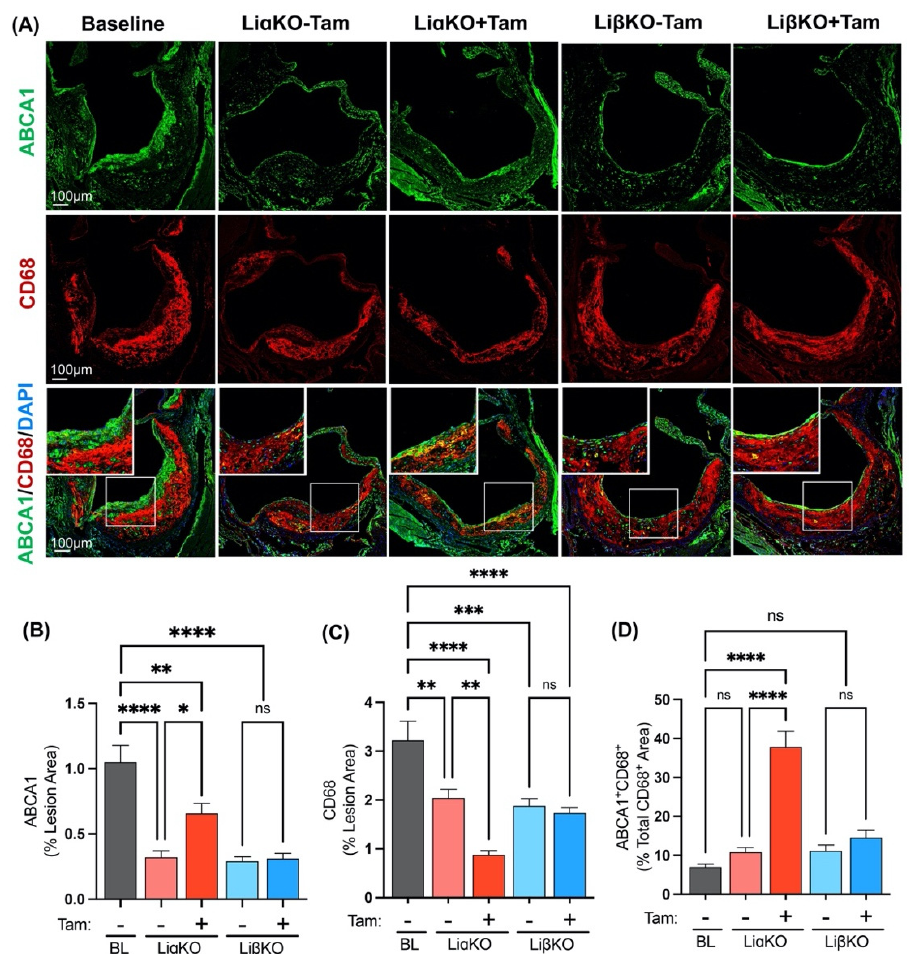
Figure 5. Elevated ABCA1 expression in GSK3 α -deficient macrophages from female Ldlr − / − mice. ( A ) Representative sections of aortic sinus immunostained with an antibody against ABCA1 (green) and co-stained with CD68 (red). Quantification of ( B ) ABCA1 and ( C ) CD68 area normalized to the total lesion area. ( D ) Quantification of co-stained (ABCA1 and CD68, yellow) area normalized to the total CD68 (macrophage, red) stained area. n = 5–7; mean ± SEM; * p < 0.05, ** p < 0.01, *** p < 0.001, **** p < 0.0001 (one-way ANOVA). ns, not significant; Tam, tamoxifen; BL, baseline; ABCA1, ATP-binding cassette transporter.